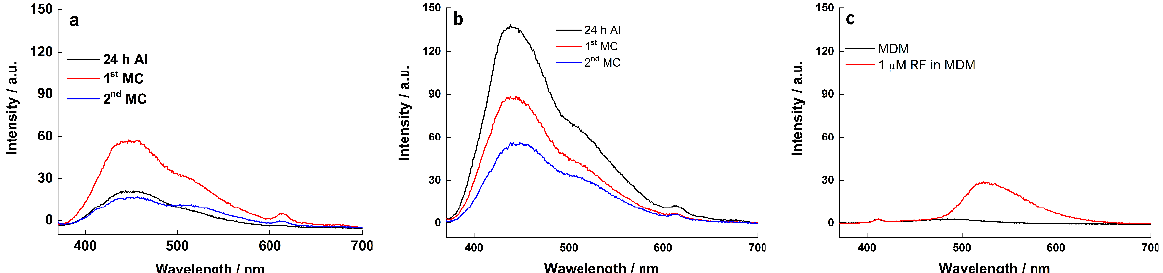
Figure 9. Fluorescence spectroscopy of medium suspension at different biofilm ages on ( a ) graphite electrode; ( b ) RVC electrode; ( c ) sterile control.